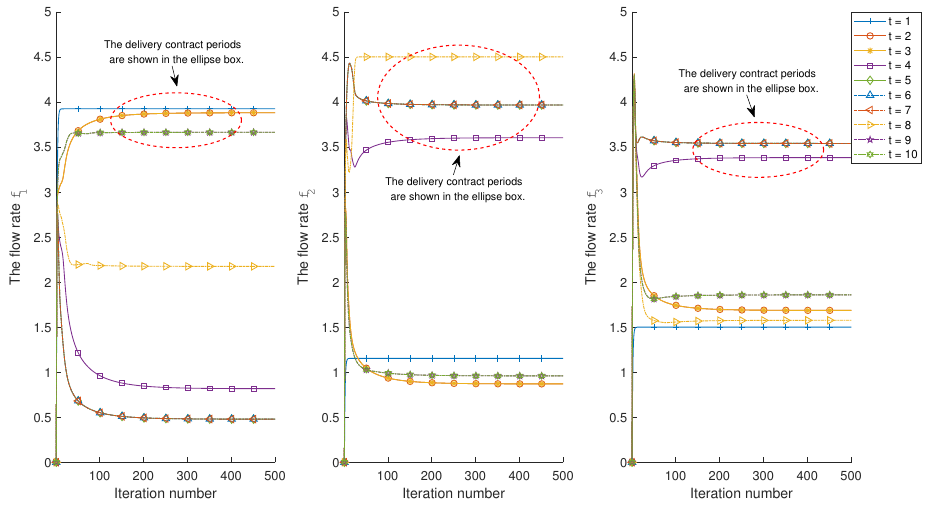
Figure 5. The impact of the timeliness of multi-source heterogeneous data on flow